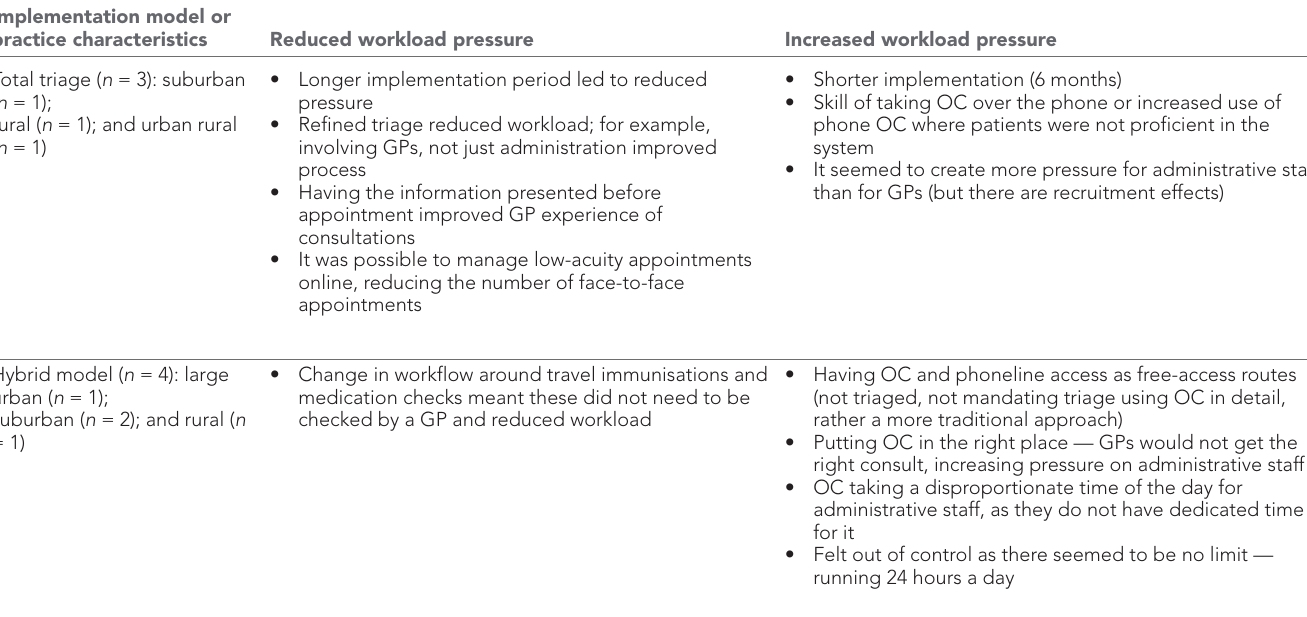
Table 3 Summary of differences in workload pressure experiences related to implementation model and stage Implementation model or practice